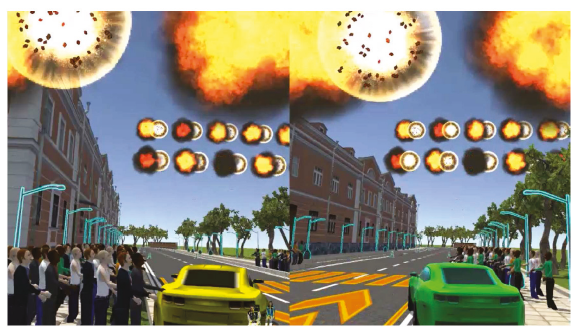
Figure 6: Celebration screen after a stage